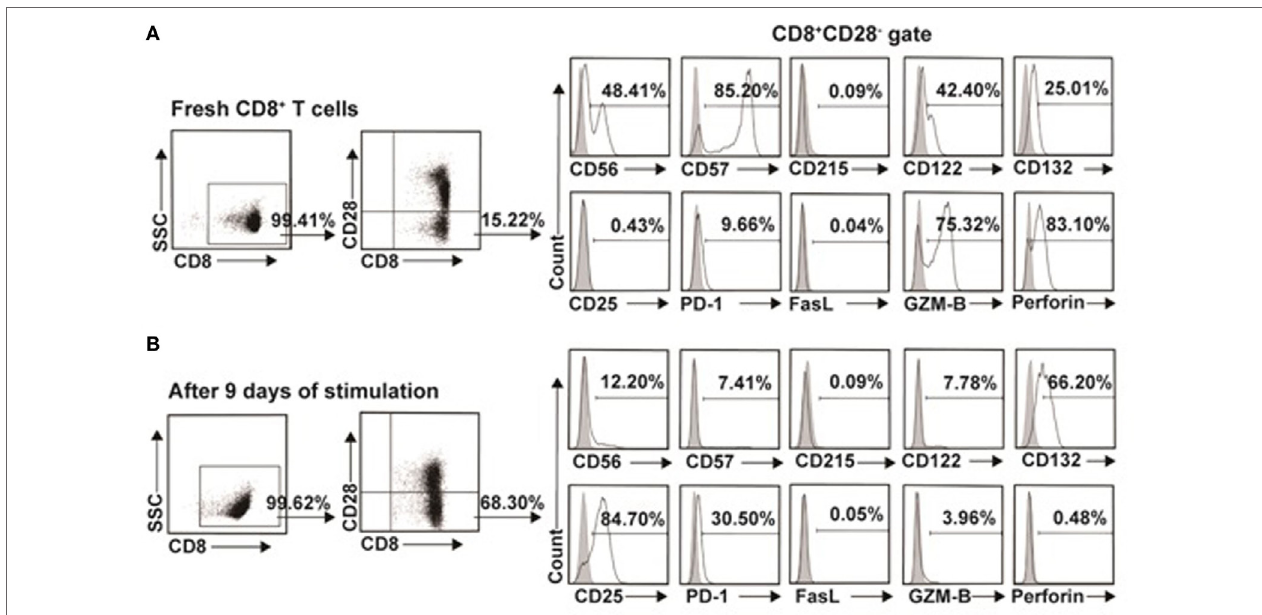
FigUre 7 | Phenotypic characteristics of freshly isolated and in vitro expanded CD8 + CD28 − T cells. (a) CD8 + CD28 − T cells freshly isolated from healthy volunteers or (b) in vitro expanded by IL-15 plus donor antigen-presenting cellss for 9 days were analyzed for cell surface or intracellular markers by multichromatic flow cytometry. Data shown were representative of three independent